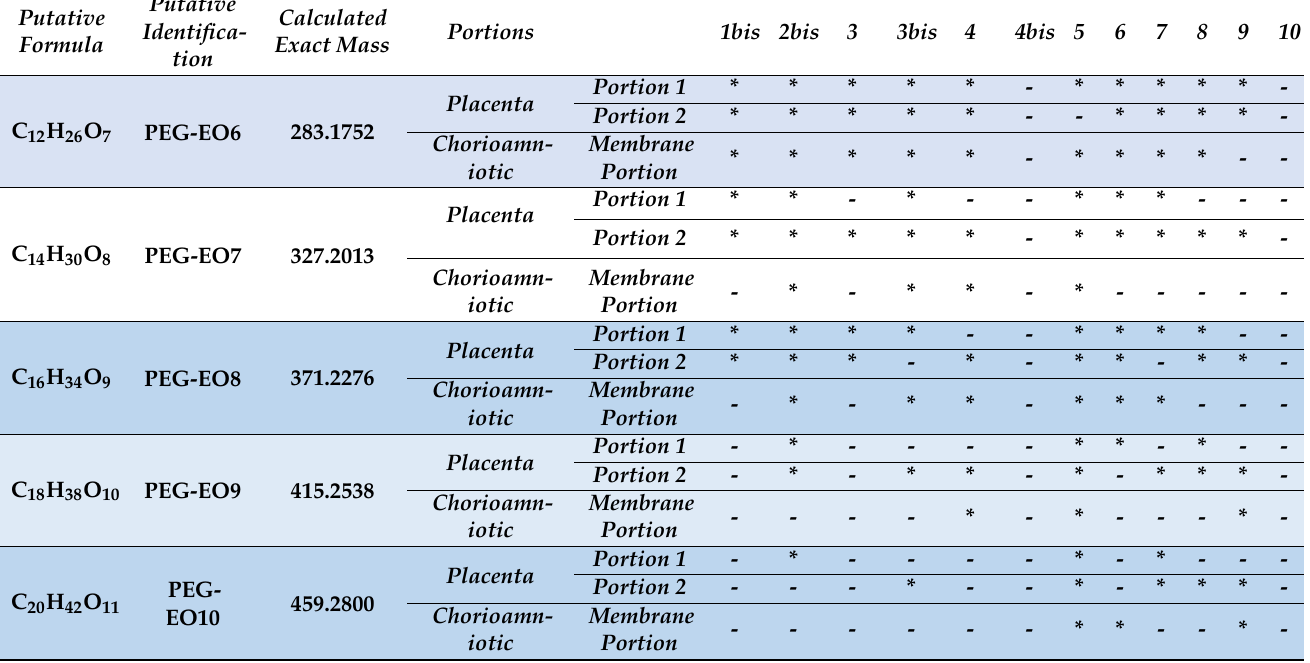
Table 1. Identification of different masses of ethylene oxidative with 4 monomers to 10 monomers (EO-4 to EO-10) of PEGs in portion 1 and portion 2 from the placenta and the membrane portion. The symbol “*” represents the presence of the PEG fragment in the